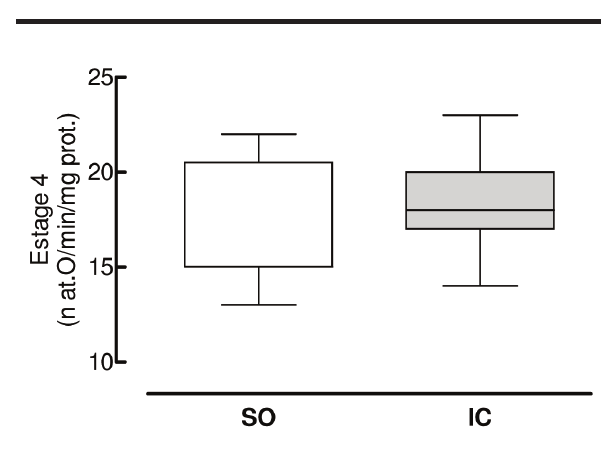
FIGURE 2 - Oxygen consumption for stage 4 mitochon- drial respiration expressed as n atoms/ oxygen/minute/mg of mitochondrial protein for both groups studied: SO (17.2 ± 3.3) and IC (18.1 ± 2.8). Group SO vs Group IC ( p>0.05).